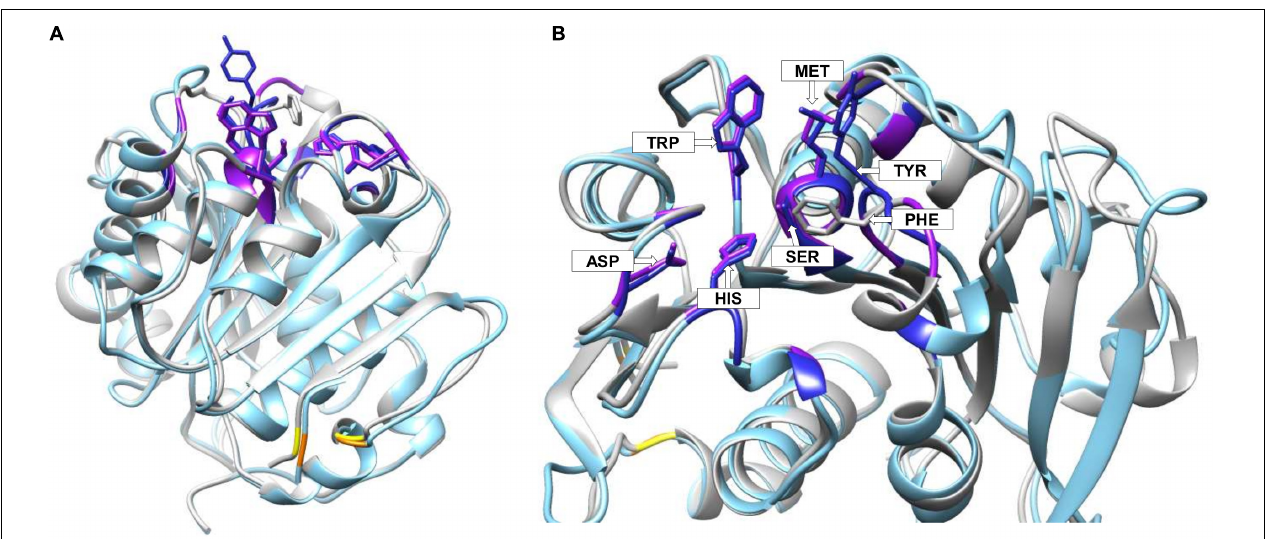
FIGURE 4 | BgP structure (light blue) superimposed onto Cut190 (gray, PDB code: 4WFI) for comparative analysis. On the left view (A) the model is shown in full. On the right view (B) , a close-up of the active site pocket is shown. Potential ligand binding residues are displayed for BgP in dark blue, while any corresponding Cut190 residues, that are also conserved in BgP, are colored in purple. Key amino acid residues are shown in stick format, and in view (B) they are labeled using their 3-letter code. With the exception of tyrosine in BgP, which is replaced by phenylalanine in Cut190, these highlighted residues are identical in both enzymes. Disulfide bond cysteines are highlighted in yellow for Cut190 and in orange for